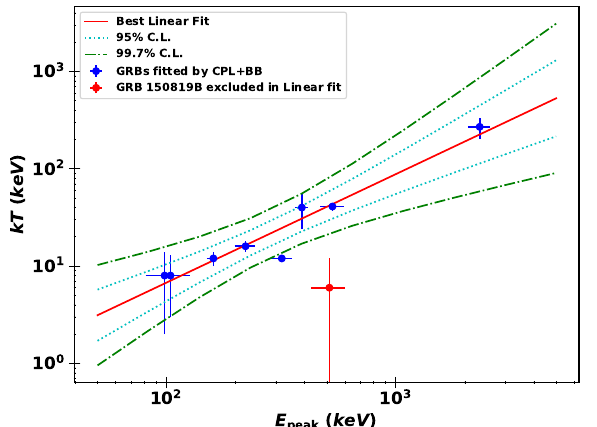
p is about 1.0 × 10 − 4 , which favors a strong correlation, as seen in Figure 4. This strong